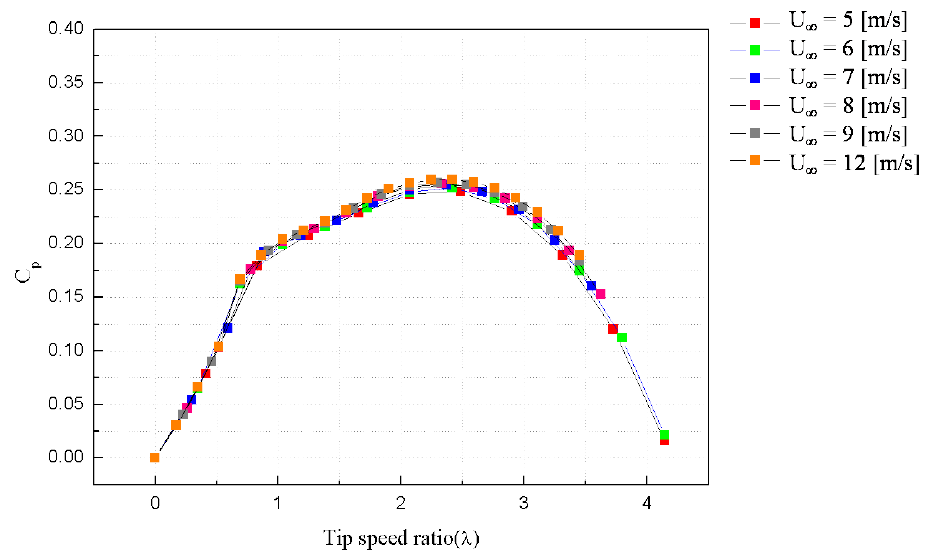
Figure 6. C p -Tip speed ratio with respect to the wind velocity.